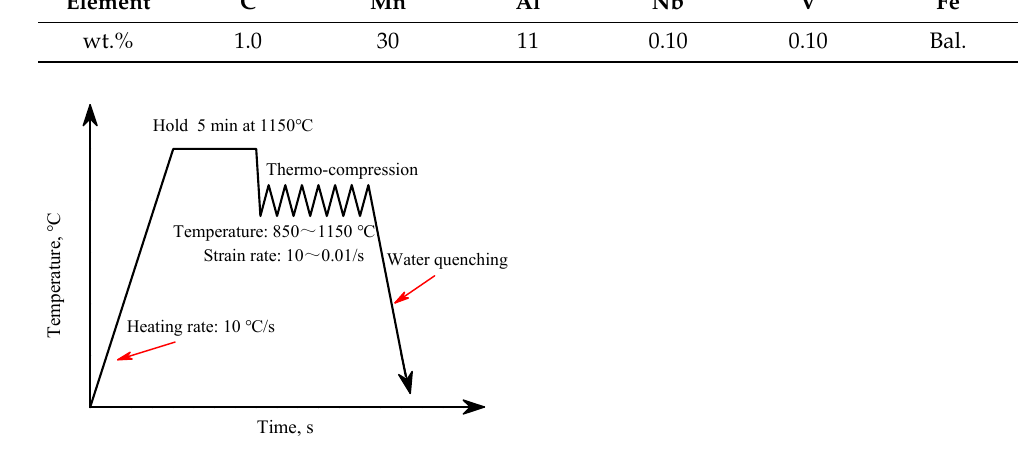
Figure 1. Thermal process diagram of compression tests for the low-density Fe-30Mn-11Al-1C-0.1Nb-0.1V steel.